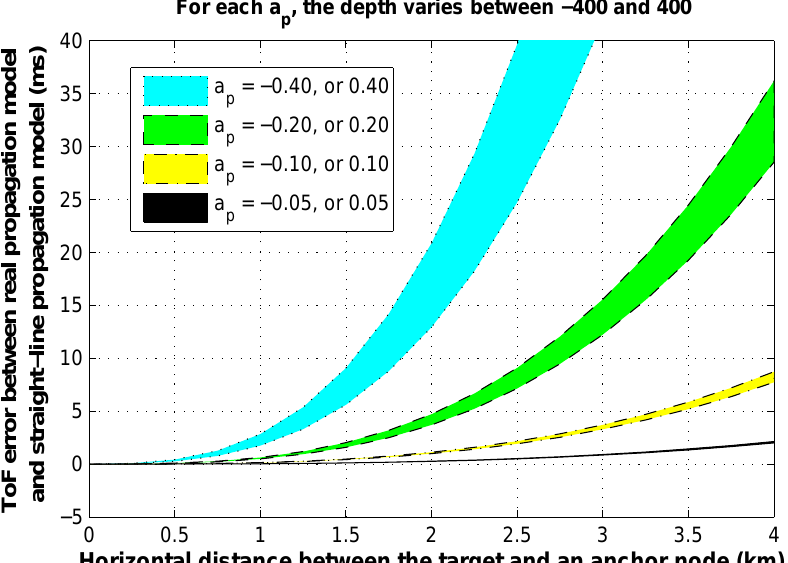
Figure 3. ToF error of the straight-line propagation model in a single layer for different values of range and